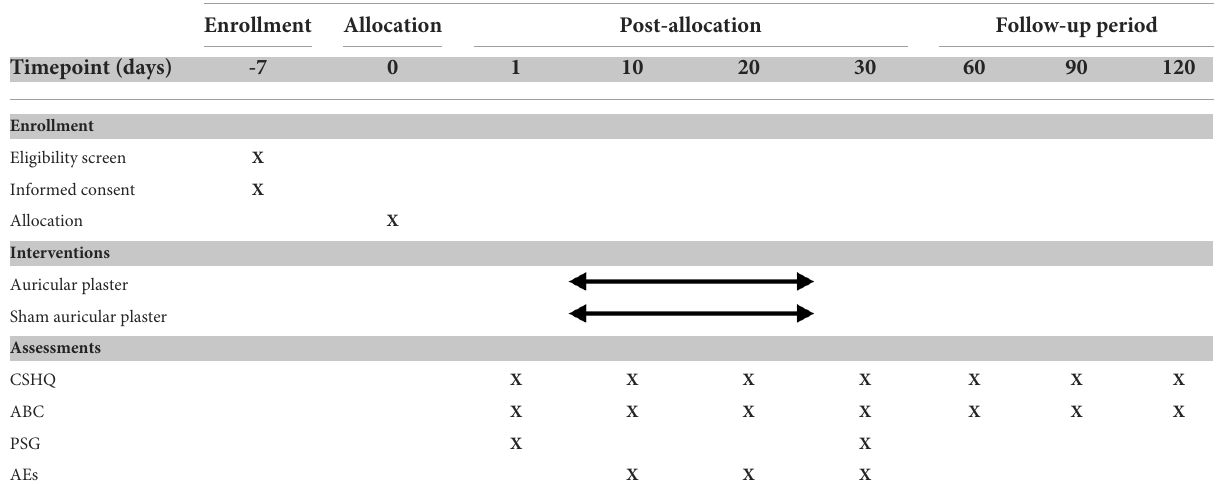
TABLE 3 Study schedule of the trial.